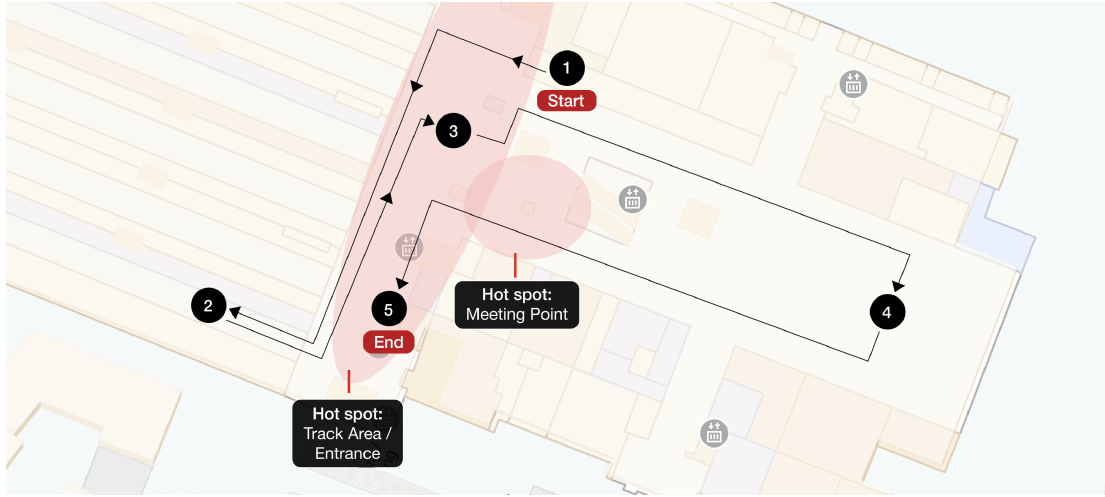
Figure 3. Sample story locations (black dots) and potential hot spots (pink overlay). Ground floor, Zurich main station.